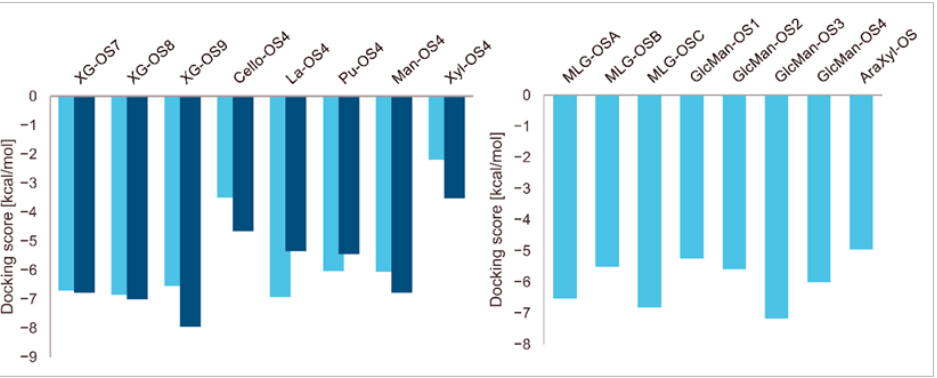
Figure 1. Induced fit docking score parameters of selected acceptor substrates docked into the active sites of TmXET6.3 (bright blue) and PttXET16A (dark blue). Table 1. Abbreviations and structural formulae of the donor and a variety of acceptor oligosaccha- ride substrates.